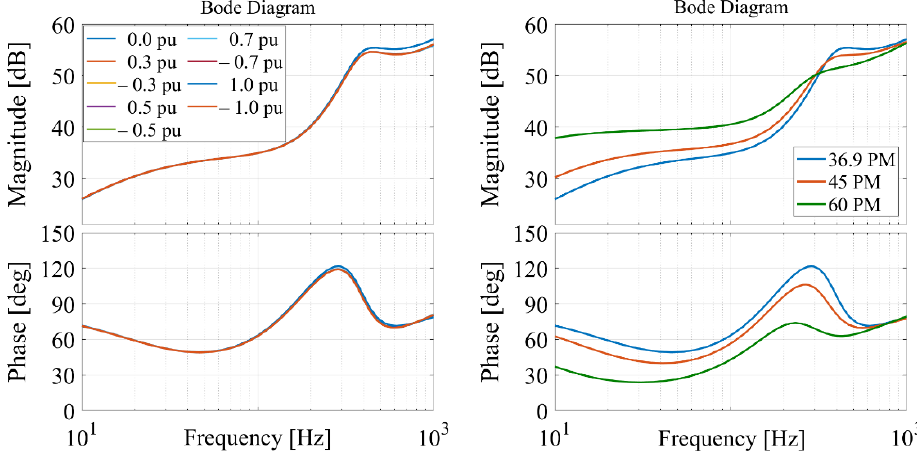
Figure 6. DC Voltage Controlling MMC for various working points ( left ) and different control parameters ( right ).